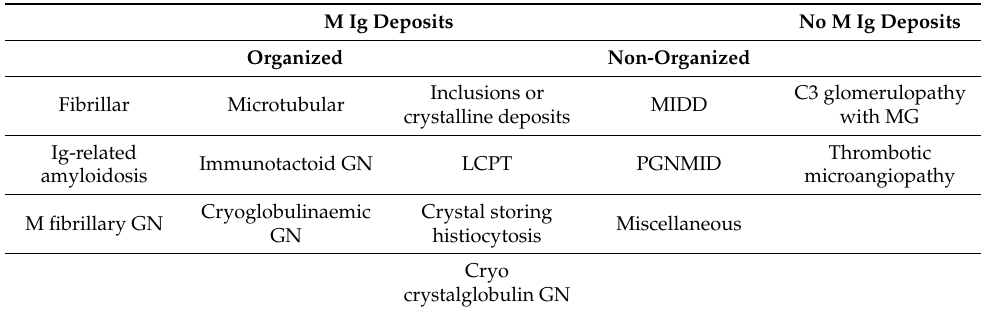
Table 4. Classification of MGRS-associated